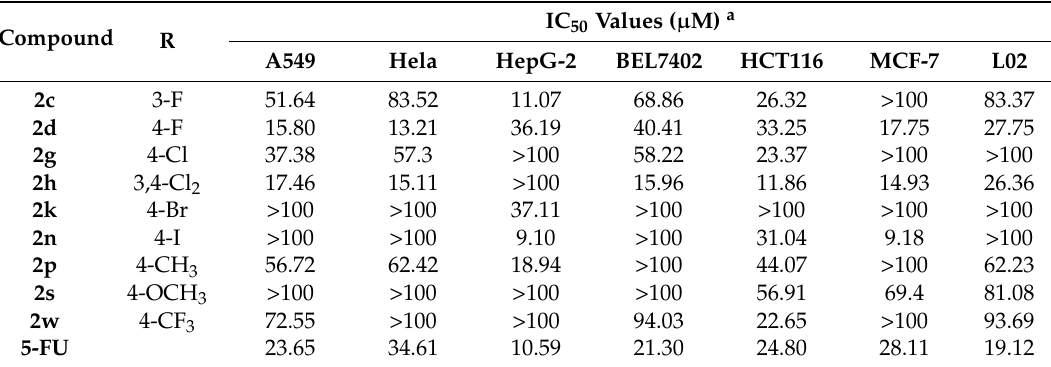
Table 2. IC 50 values ( µ M) of some active compounds.